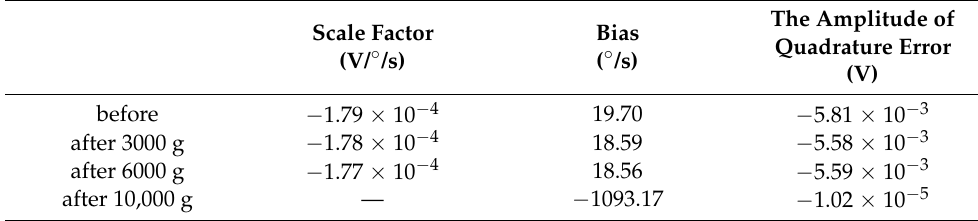
Table 2. The experimental results of scale factor, bias, and quadrature error amplitude before and after the impacts.